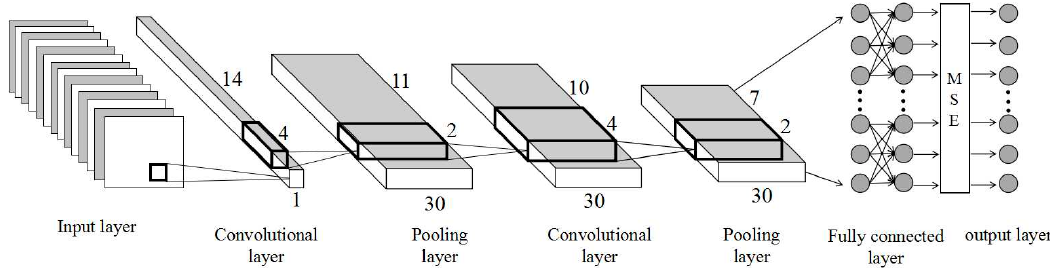
Figure 3. CNN architecture.